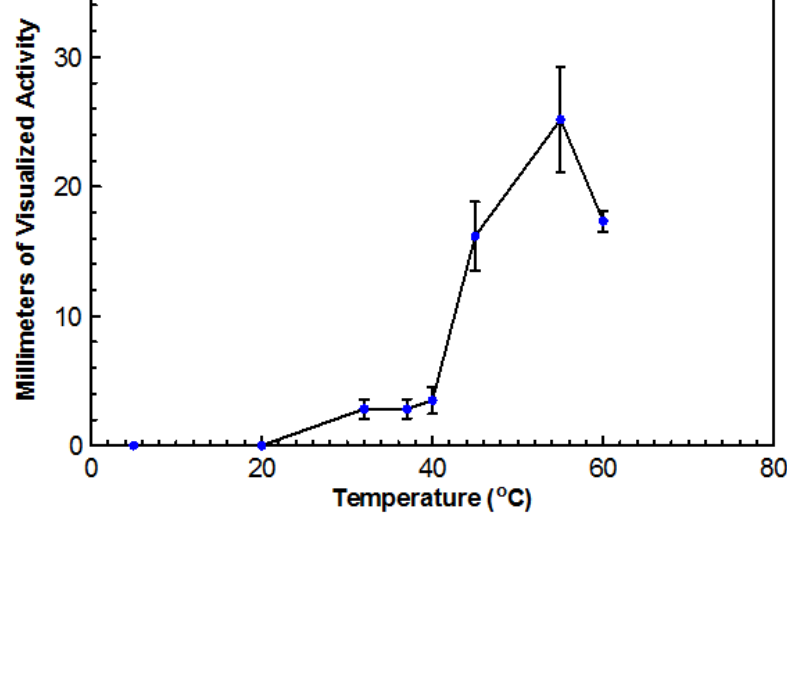
Figure 4. The effect of temperature on DNase production by TM-417. DYpSs agar plates were inoculated with a 10 mm plug taken from a stock culture plate. The plates were incubated at various temperatures (5, 32, 37, 45, 55, and 60 °C) for five days. The zones of clearing were measured in four different directions from the edge of visible growth to the furthest spot of clearing. The mean values and standard deviations from triplicate assays were